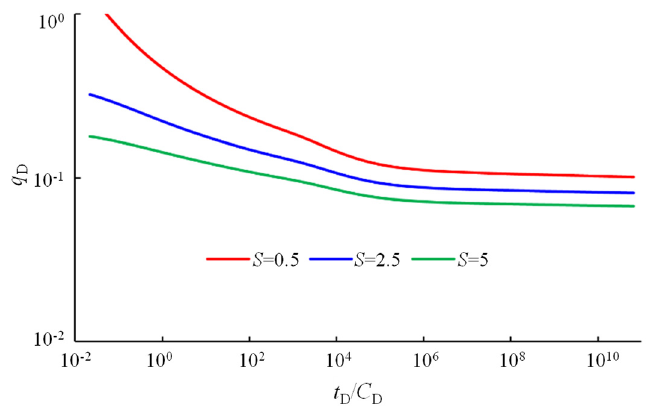
Figure 7. Relationship between skin factor and productivity.